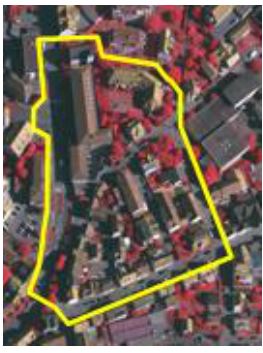
Figure 4. Test data set (yellow colour contour line